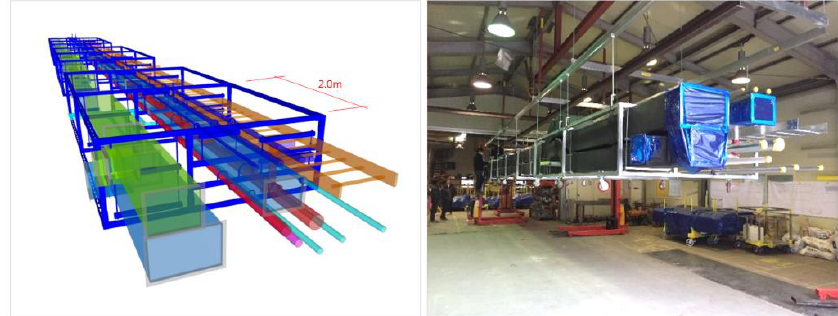
Figure 2. Type B: Frames in the form of a continuous set of cubes (supporting interval: 2 m).